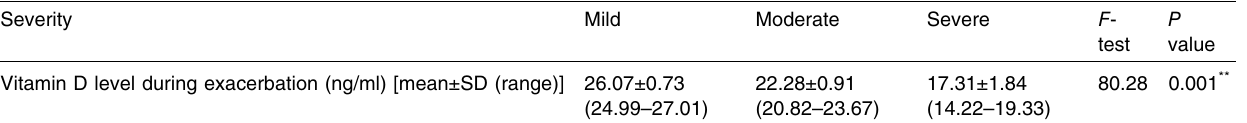
Table 3 Comparison of serum vitamin D level among mild, moderate, and severe exacerbated asthma Severity Mild